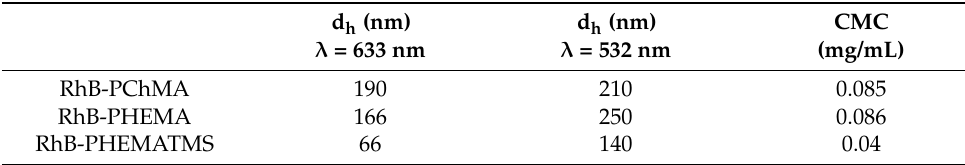
Table 2. Characteristics of polymer nanoparticles in